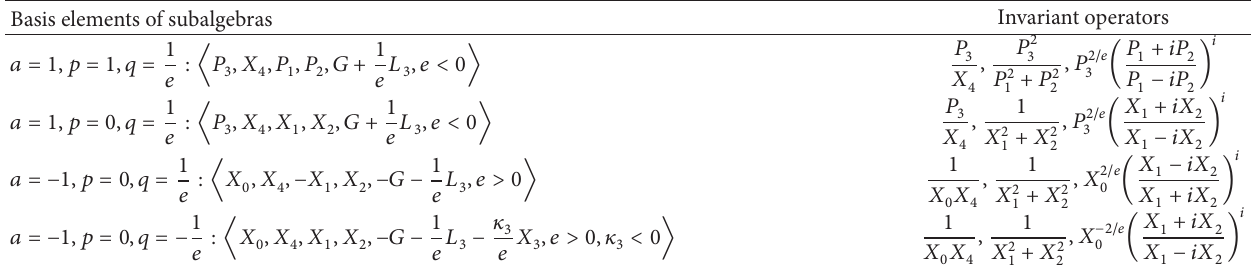
Table 21: Invariant operators of subalgebras of the type 𝐴 𝑎𝑝𝑞 5,13 .